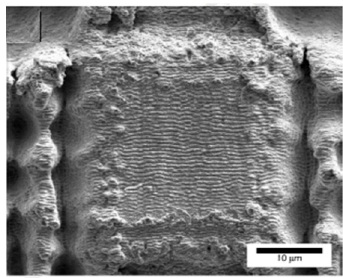
Figure 11. SEM image of laser fabricated hierarchical structures: matrix micropattern with a pitch distance of 50 µ m covered by LIPSS (Reprinted from [120], with permission from Elsevier).